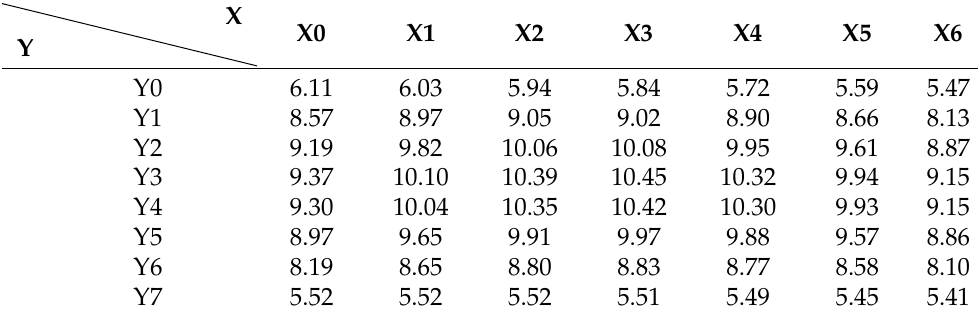
Table 2. NMOS finger equivalent substrate resistance by simulation (a.u.).